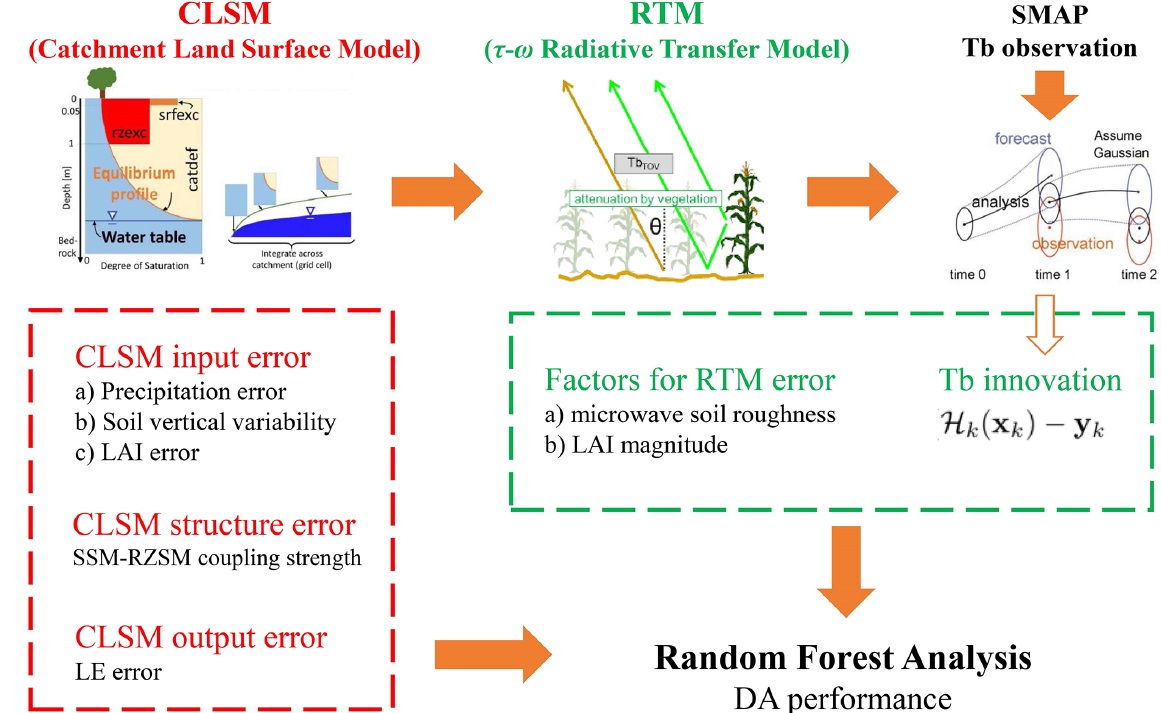
Figure 1. Systematic connection in the DA framework and the association between the eight selected factors in the